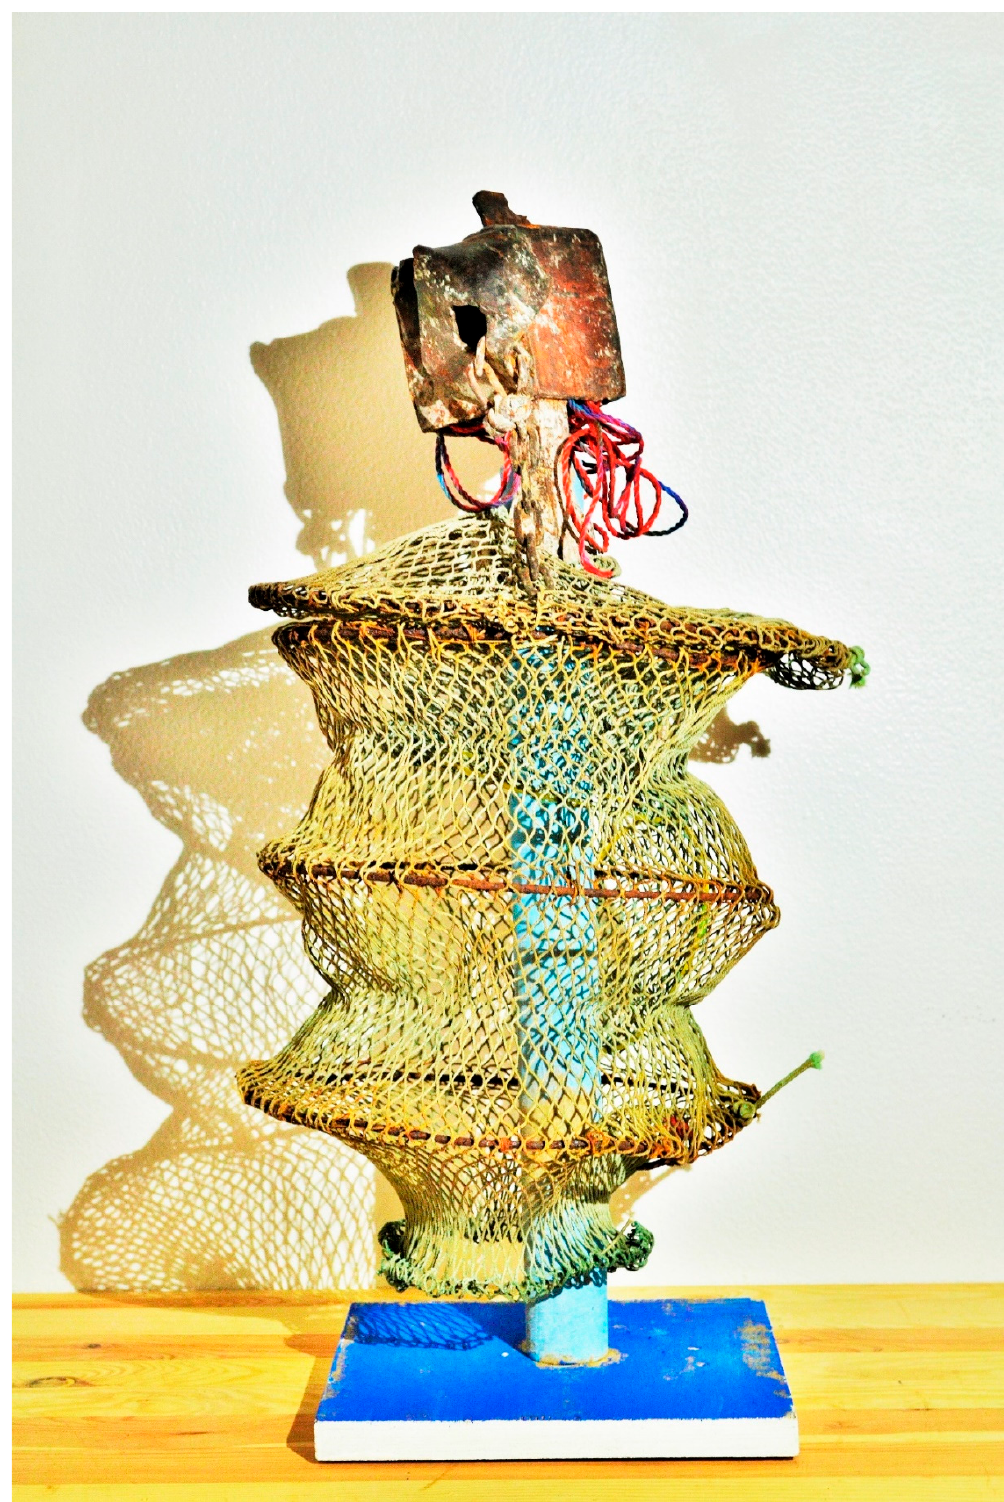
Figure 4. The Catch of the Day. Photo by Agricubismo ® .